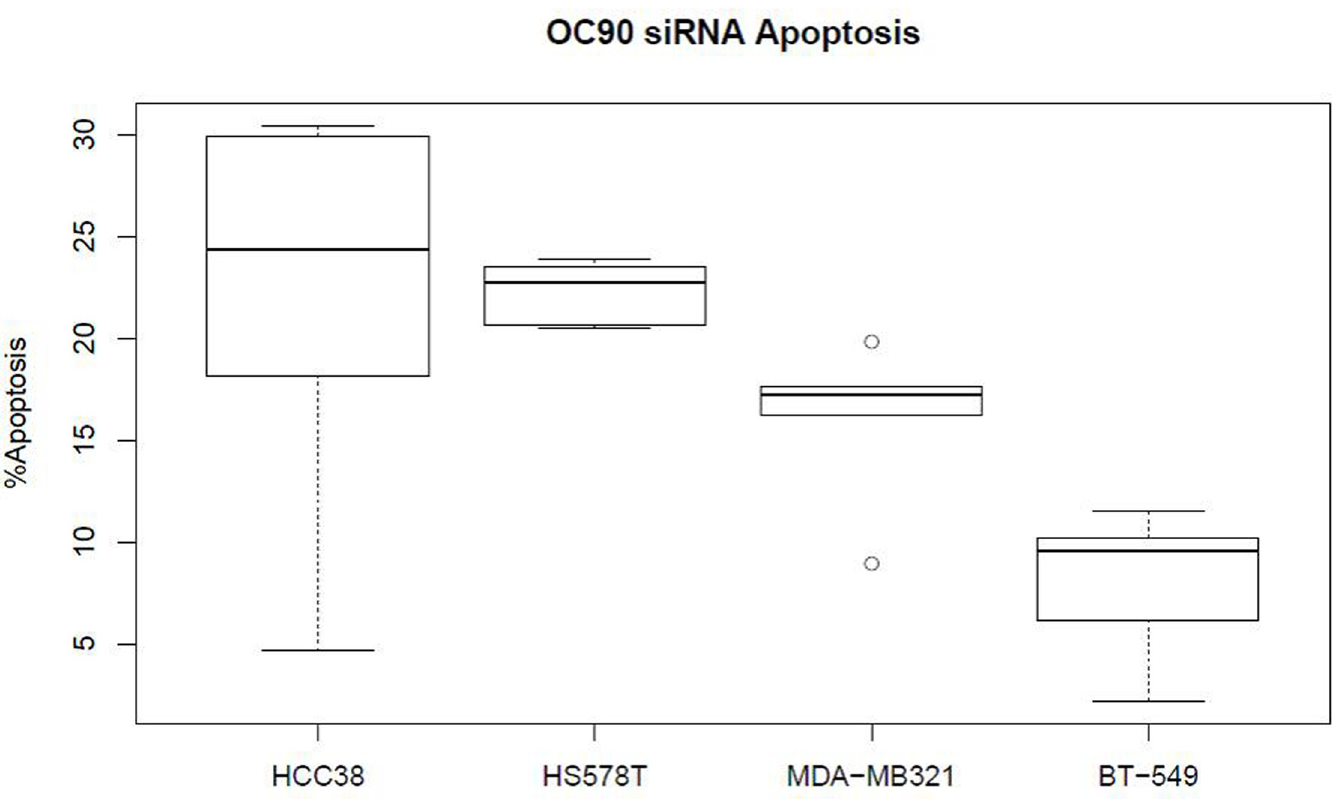
Fig 3. OC90 knockdown increases cellular apoptosis in some TNBC cell lines. Box plots shows relative number of apoptotic cells (X-axis) 72 hours after OC90 knockdown compared to vector control SiRNA in respective TNBC cell lines (x-labels). The Y-axis %Apoptosis represents changes in apoptotic cell % compared to the control siRNA